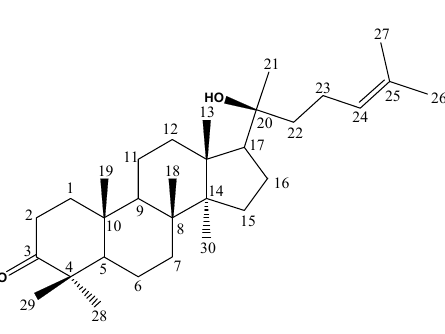
Figure 5. The structure of 20-hydroxy-24-dammaren-3-one.